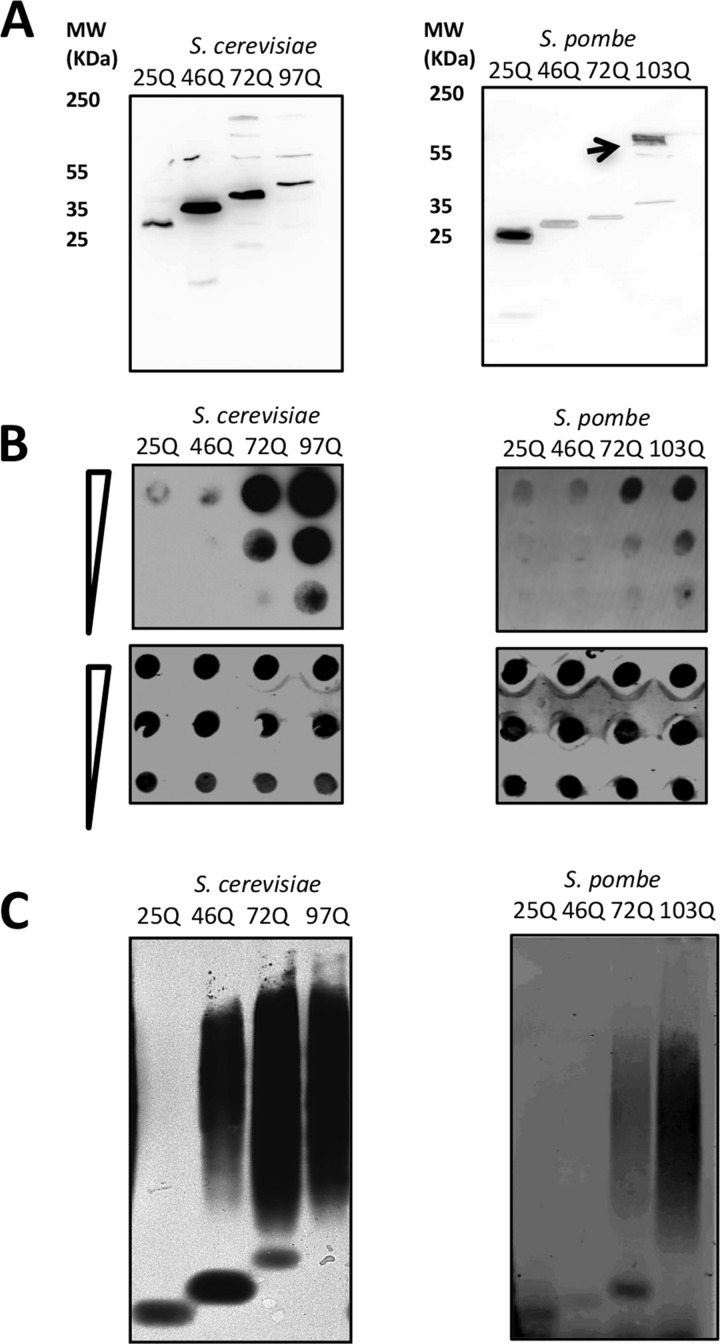
Detection of Htt protein aggregates in S. cerevisiae and S. pombe. (A) Left, Western blot analysis of S. cerevisiae htt-25Q, htt-46Q, htt-72Q, and htt-103Q using detection of an N-terminally fused FLAG tag with an arrow indicating a higher-molecular-mass aggregate; right, Western blot analysis of S. pombe htt-25Q, htt-46Q, htt-72Q, and htt-103Q using detection of an N-terminally fused FLAG tag. (B) Filter retardation assay of Htt-25Q-GFP, 46Q-GFP, 72Q-GFP, and 97Q-GFP expressed in S. cerevisiae (left) in 5-fold dilutions (top) and of the same strains with no SDS treatment (bottom) and filter retardation assay of Htt-25Q-GFP, 46Q-GFP, 72Q-GFP, and 103Q-GFP expressed in S. pombe (right) in 5-fold dilutions (top) and of the same strains with no SDS treatment (bottom). (C) SDD-AGE of S. cerevisiae expressing Htt-25Q-GFP, 46Q-GFP, 72Q-GFP, and 97Q-GFP (left) and of S. pombe expressing Htt-25Q-GFP, 46Q-GFP, 72Q-GFP, and 103Q-GFP (right) as detected by anti-FLAG antibody.